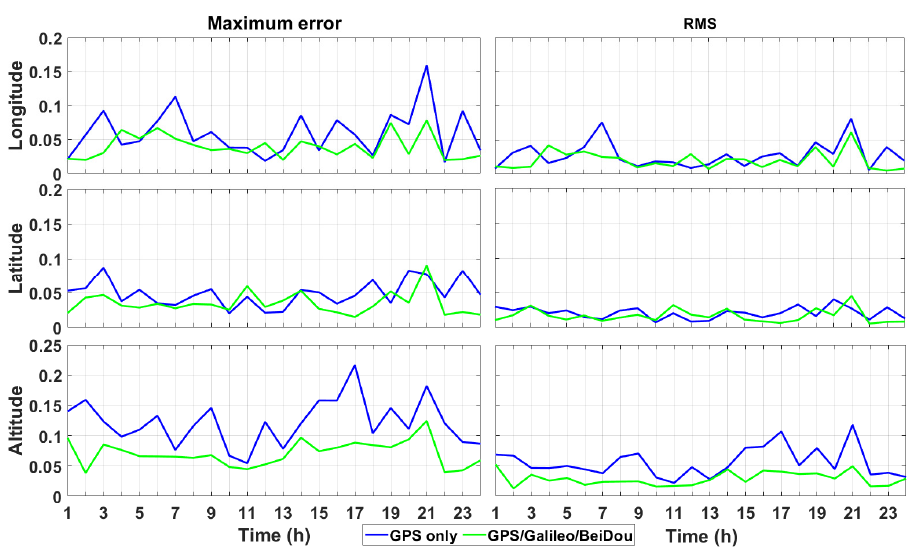
Figure 7. Statistical results (both of the maximum error and RMS were expressed in metres) of the proposed time-relative positioning method obtained by using only GPS and GPS/Galileo/BeiDou.